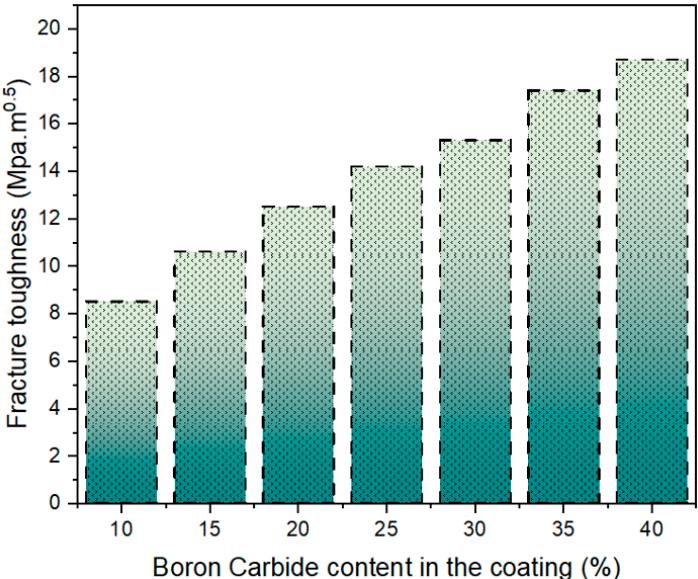
Figure 8. The fracture toughness of different B 4 C /Ni63 coatings.